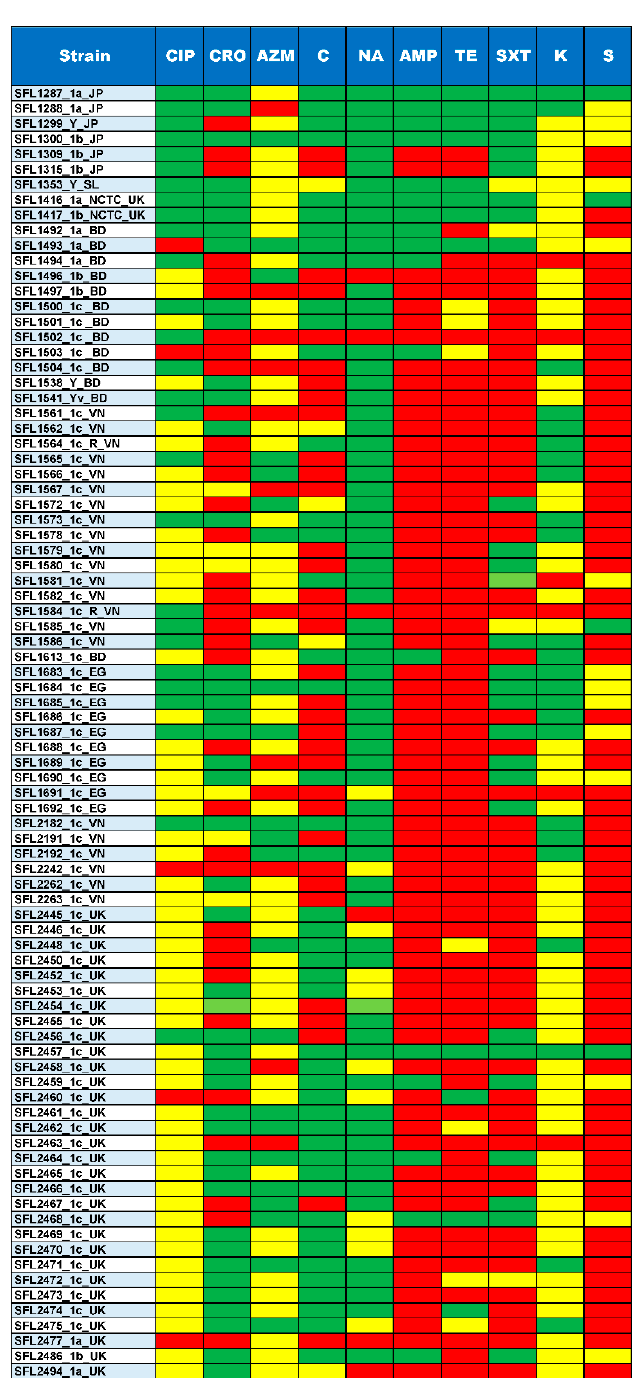
Figure 5. Antibiotic resistance gene profiles. The top row shows the list of antibiotic resistance genes and the left column shows the list of strains. The presence and absence of antibiotic resistance genes in each of the strains is shown in red and green colors, respectively.